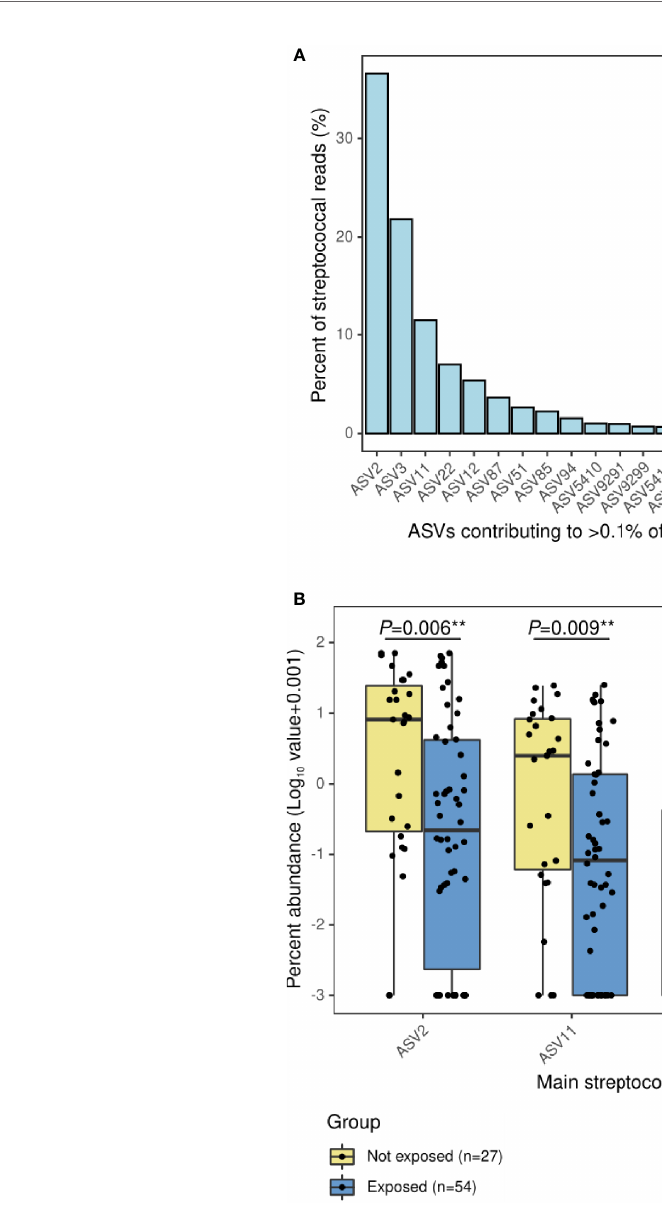
FIGURE 2 | Main ASVs assigned to Streptococcus in the nasopharynx of children with IPD and their relative abundance according to antibiotic-exposure groups. (A) Bar plot showing the ASVs with a relative contribution >0.1% to the total number of streptococcal reads. (B) Boxplot showing the relative abundance of main streptococcal ASVs differentially represented in antibiotic-exposure groups. Signi fi cance codes: *** ≤ 0.001; ** ≤ 0.01; * ≤